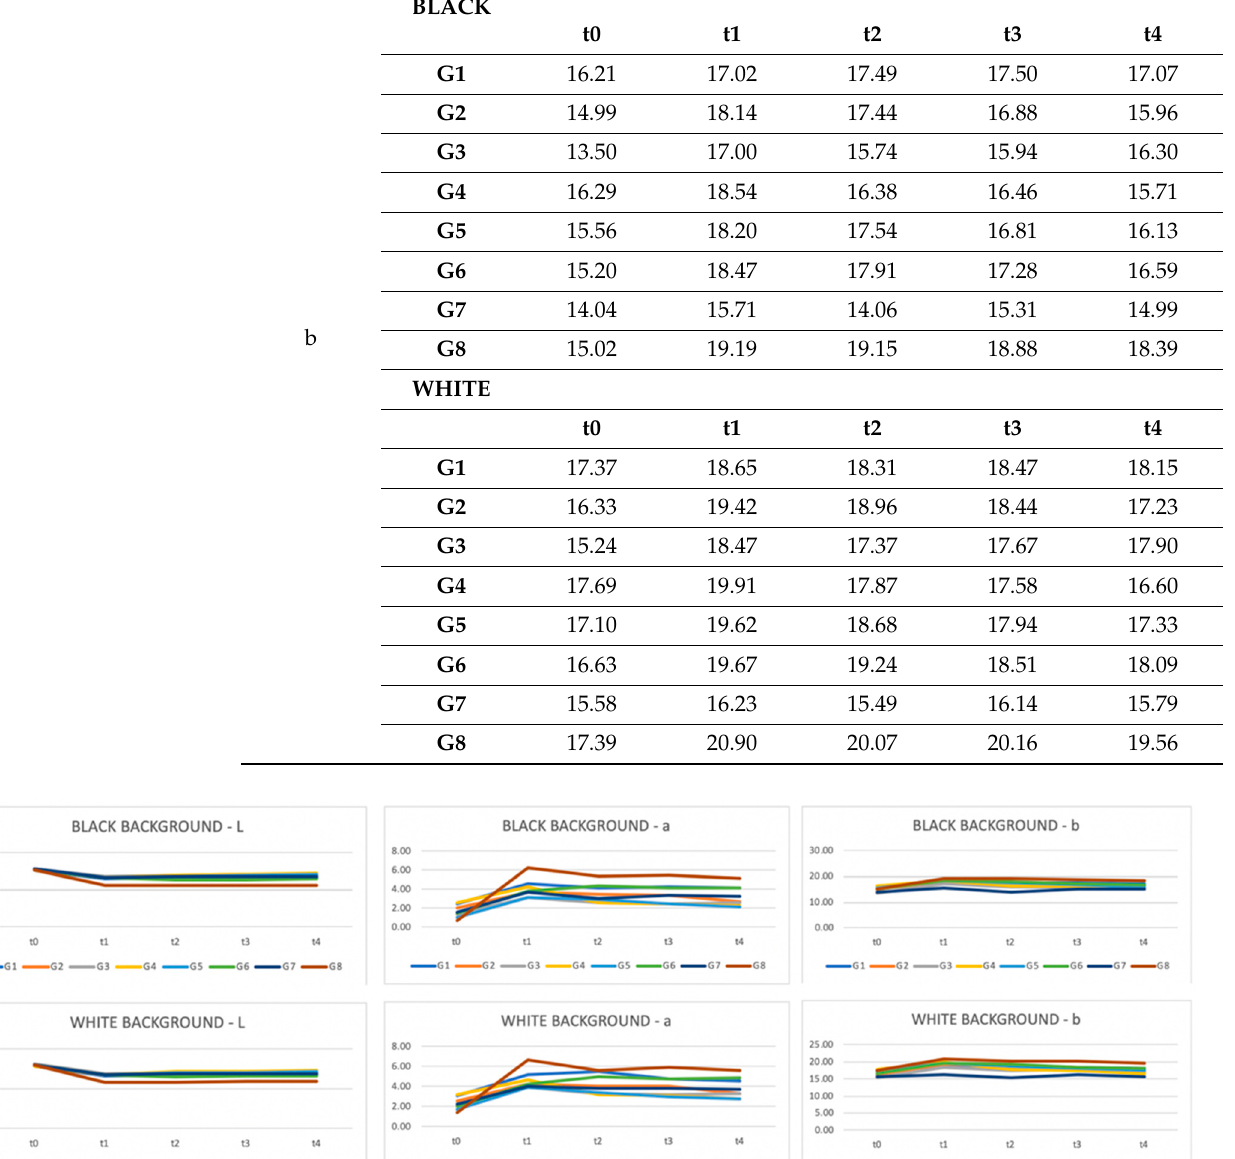
Figure 5. L*a*b* change over time for every bleaching agent over a black and a white background.